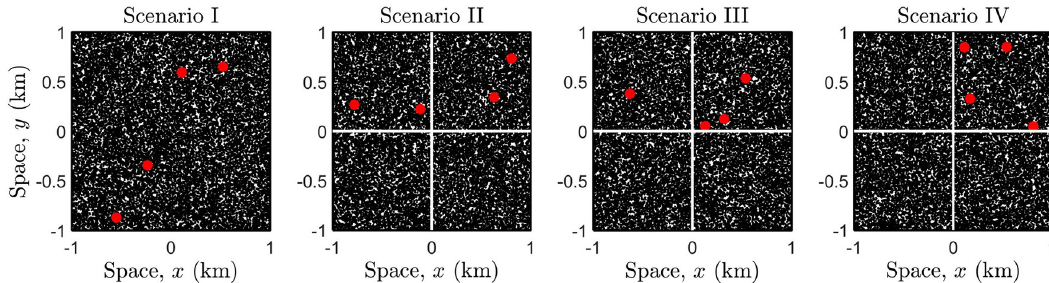
Fig 4. Lockdown scenarios in the case of a homogeneous population spatial